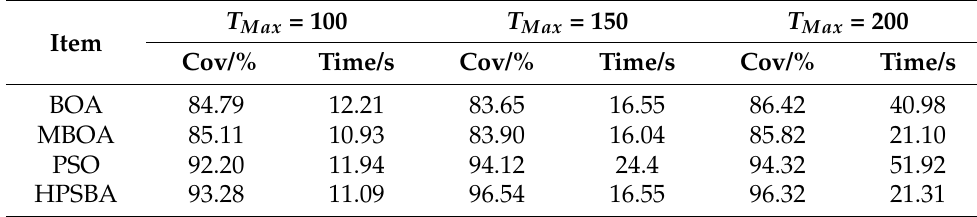
Table 7. Node coverage rate of different iterations.